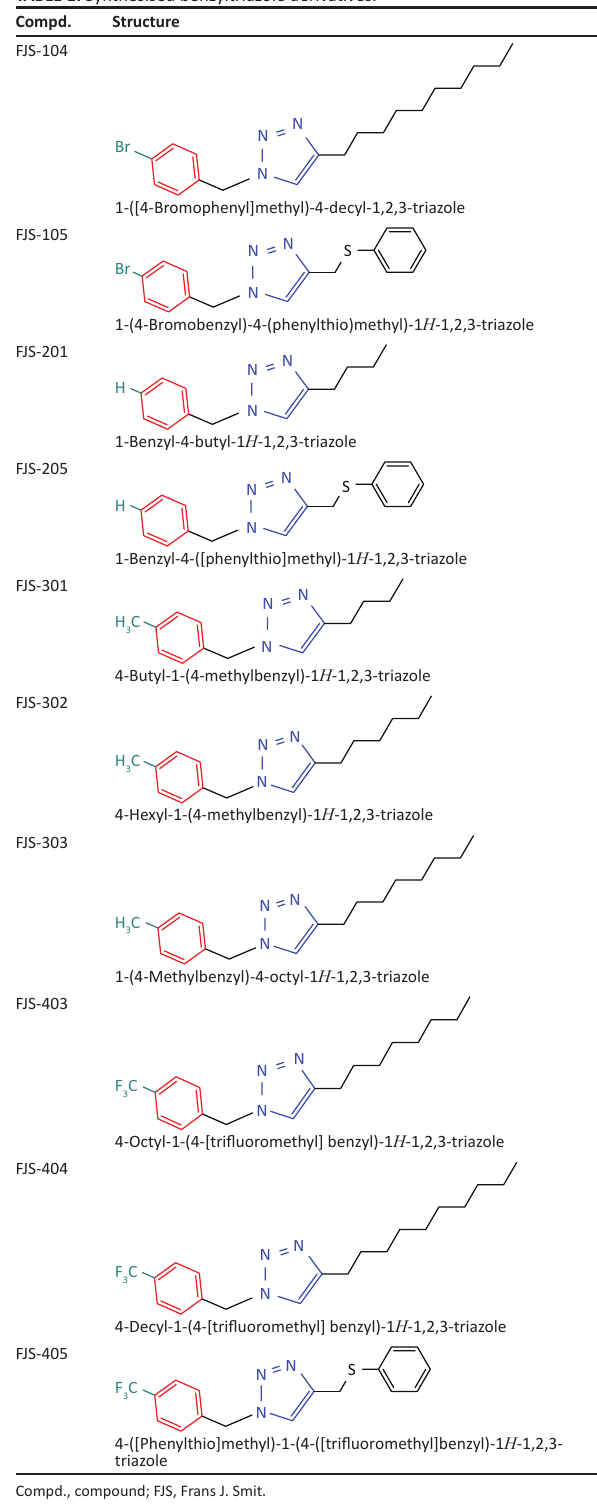
TABLE 1: Synthesised benzyltriazole derivatives.